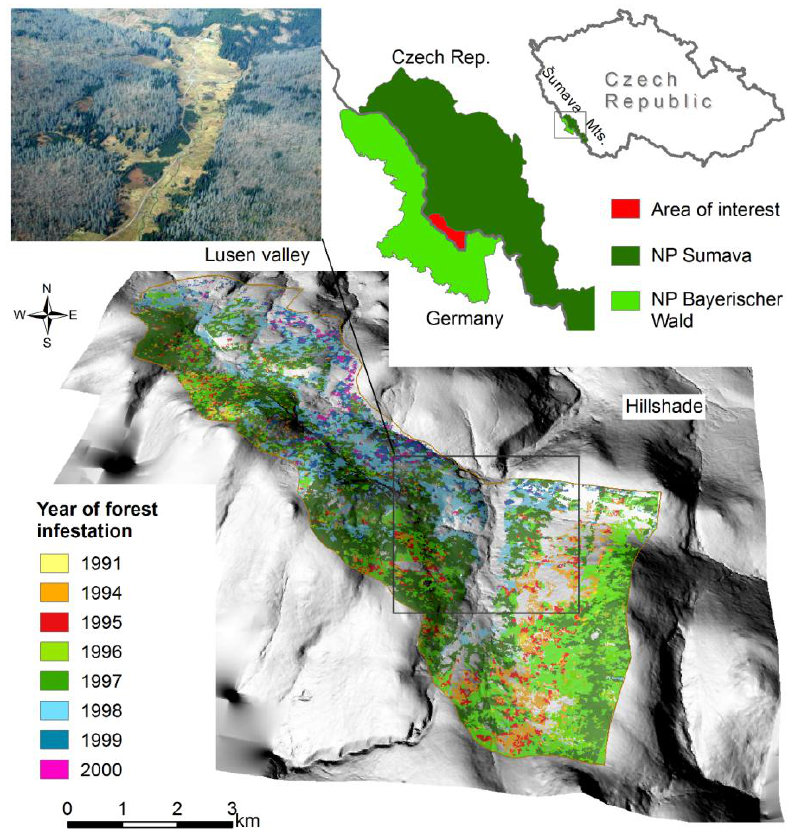
Figure 1. Study area located in the Šumava Mountains, Czech Republic–Germany border region.